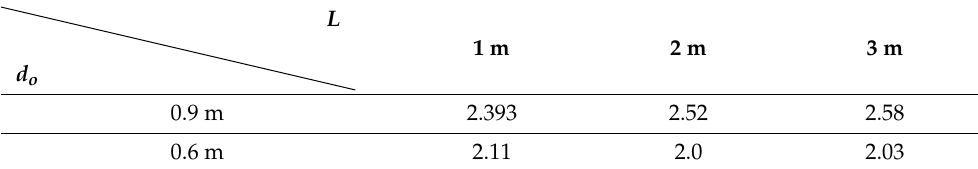
Table 3. Froude number in the absence of the mitigation wall and building at the time of F n,max .